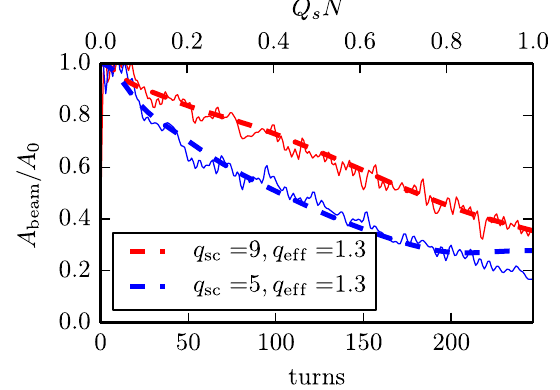
simulations.FIG. 16. Decoherence with space charge from the measure- 4 × 10 9 , the blue solid line is ments: the solid red line is for N p ¼ 1 . 6 × 10 9 . The dashed lines are from simulations with for N p ¼ the fitted q . sc